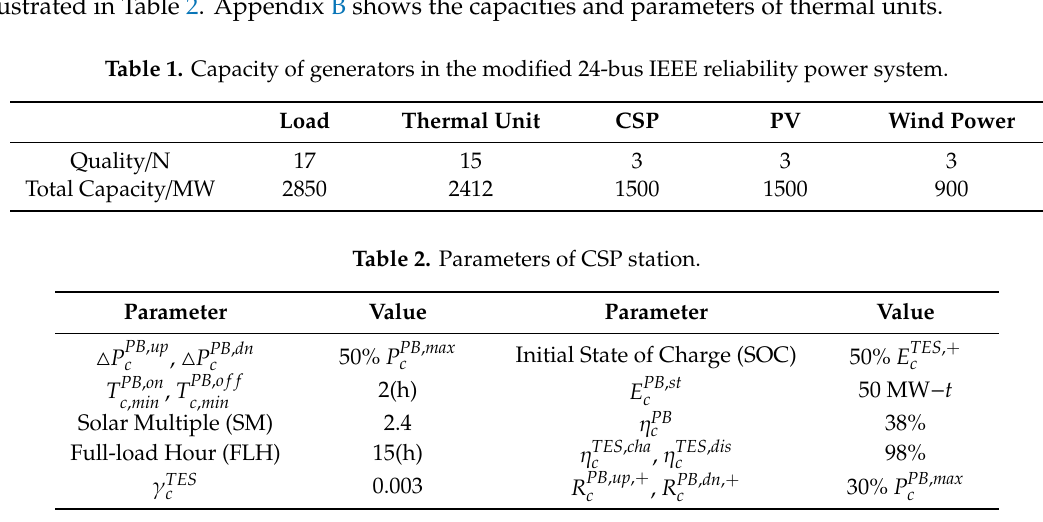
Table 2. Parameters of CSP station.